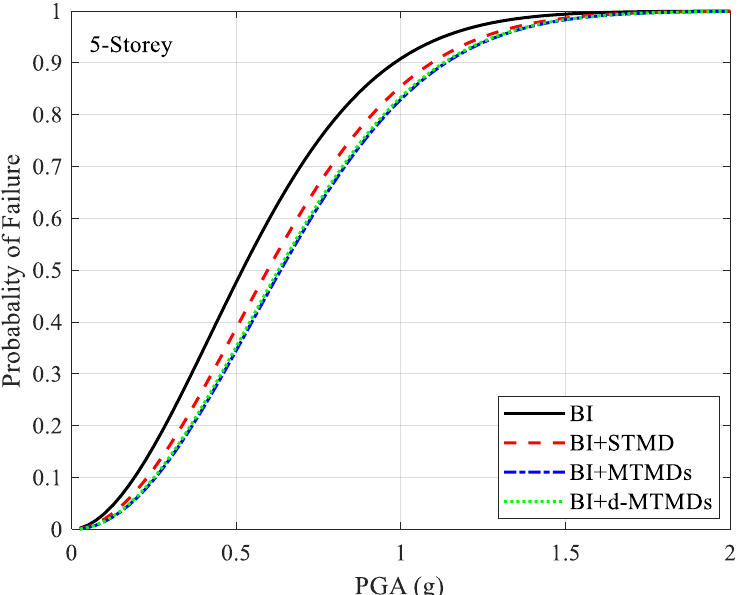
Figure 10. Bearing displacement simplified fragility curves for 5-story base-isolated building equipped with TMDs.